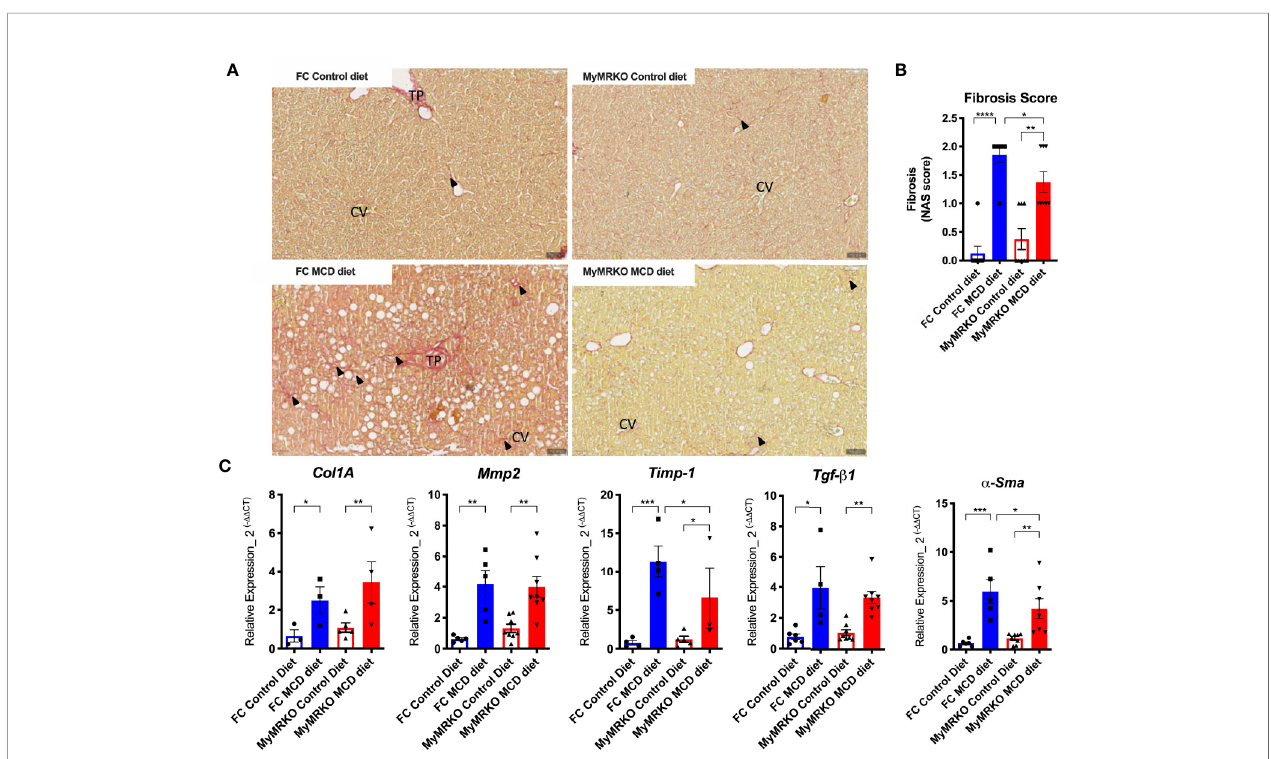
FIGURE 2 | Floxed control (FC) and myleoid mineralocorticoide receptor knockout (MyMRKO) fed with methionie and choline de fi cient diet (MCD) diet display liver fi brosis and increased expression of fi brosis markers. Additional criteria of the NAFLD activity score (NAS) score ( Figure 1 ) are the fi brosis signs, as shown in (A) . In this line, the hepatic stellate cells (HSC) are a key modulator of hepatic fi brosis; as shown in (B) the expression of a Sma , a marker of HSC, increased in both groups of mice fed with MCD diet (C) . Expression of Col1A , Mmp2 , and Timp-1 , which are involved in hepatic fi brosis. To normalize the a Sma , Col1A , Mmp2 , Timp-1 , and Tgf- b 1 expression, we used 18S as a housekeeping gene. Each quanti fi cation was performed in duplicate from an n=4-8 animals per group. Statistical analysis was performed with one-way ANOVA comparing all treatments, with Tukey post-test. All fi gures display mean ± SEM. Statistical differences were considered signi fi cant according to *p < 0.05 **p < 0.01 ***p < 0.001 ****p <